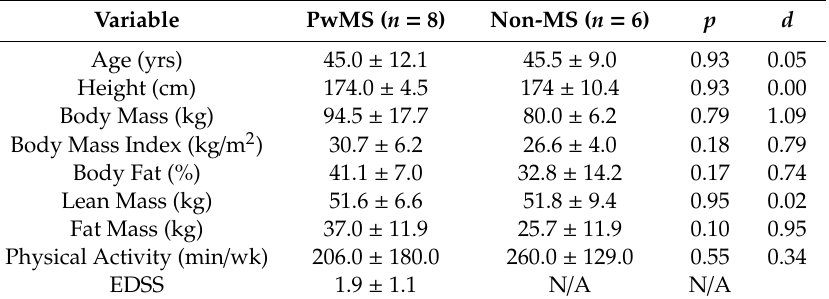
Table 1. Participant characteristics.